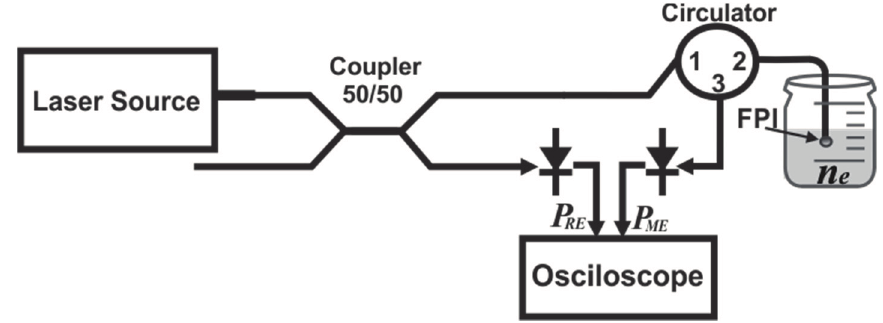
Figure 1. Refractive index sensing